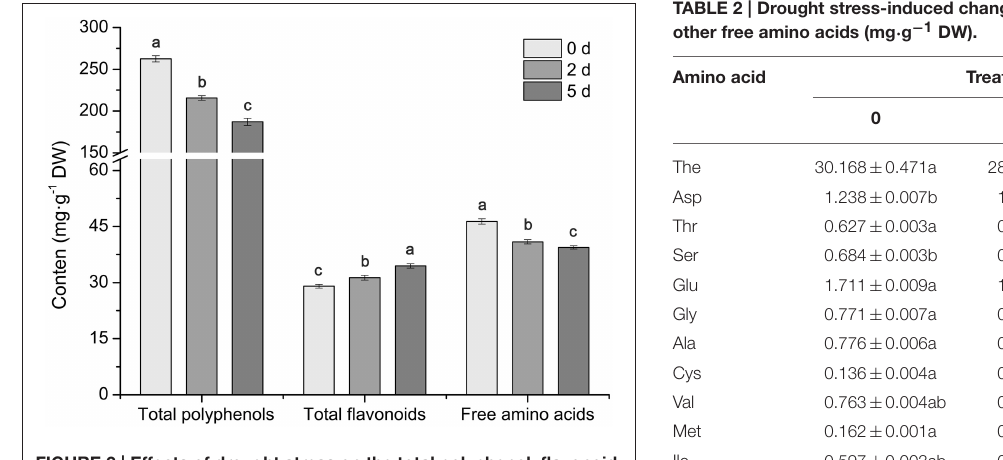
FIGURE 2 | Effects of drought stress on the total polyphenol, flavonoid and free amino acid content in C. sinensis leaves. Drought stress significantly decreased the amount of total polyphenols and free amino acids and increased the total flavonoids. Values are presented as the mean ± SD from three independent experiments, and different letters indicate significant differences at P < 0.05 according to Duncan’s test.